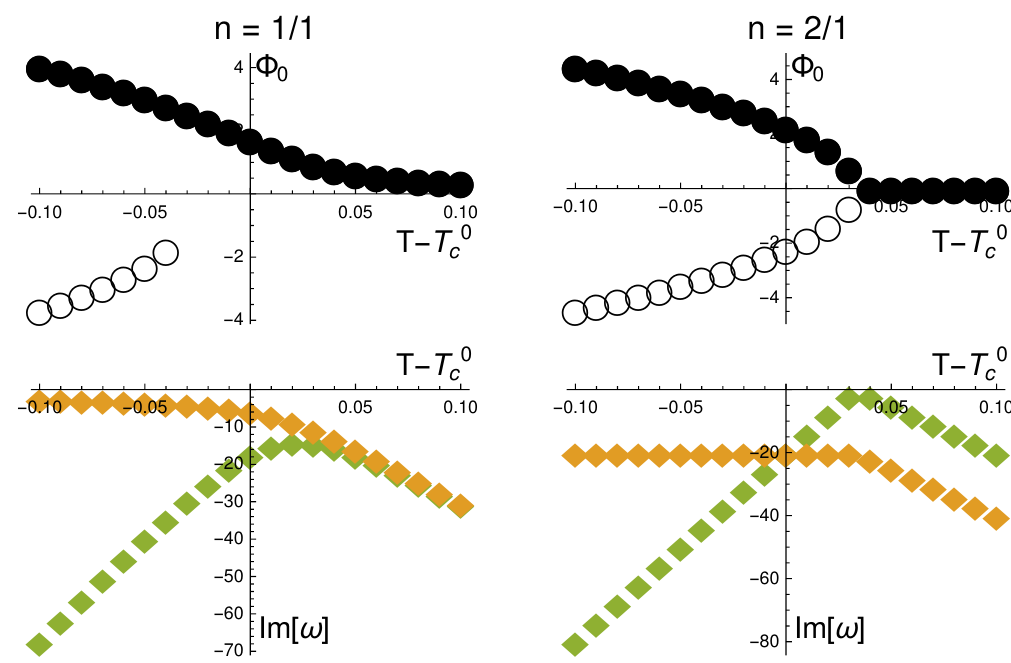
Figure 13. Comparison of the cases with and without residual Z 2 symmetry. The left column corresponds to 1 / 1 -commensurate case in terms of [54], where no residual symmetry is present. The right column depicts 2 / 1 -commensurate case with spontaneous residual Z at critical